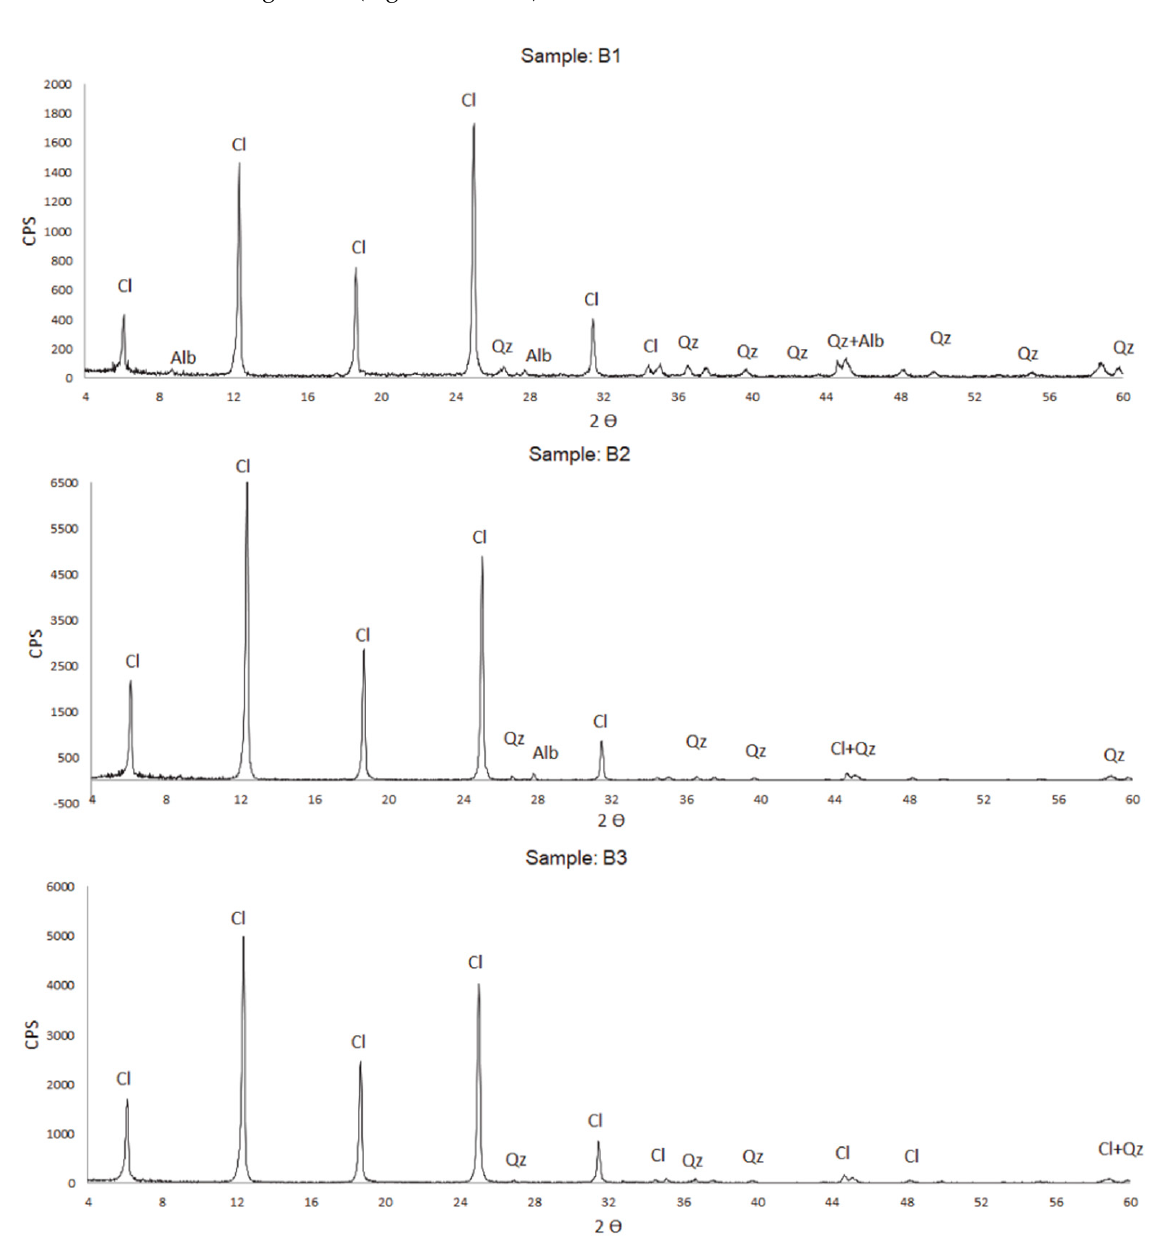
Figure 6. XRD analysis of stone moulds Samples B1–B3. Cl = clinochlore; Qz = quartz; Alb = albite.